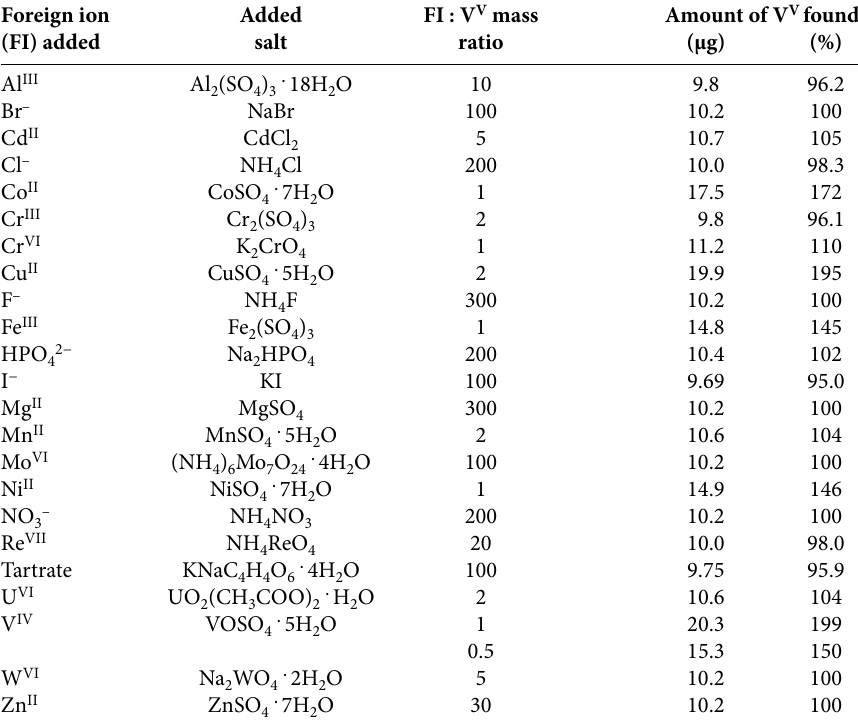
Table 2. Effect of foreign ions in determination of 10.2 µg of V V